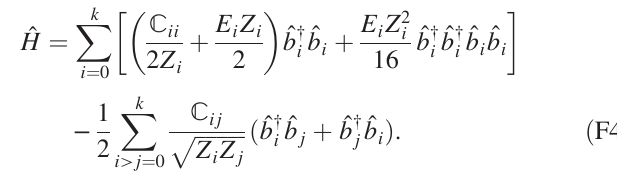
while the second line represents the excitation exchange.